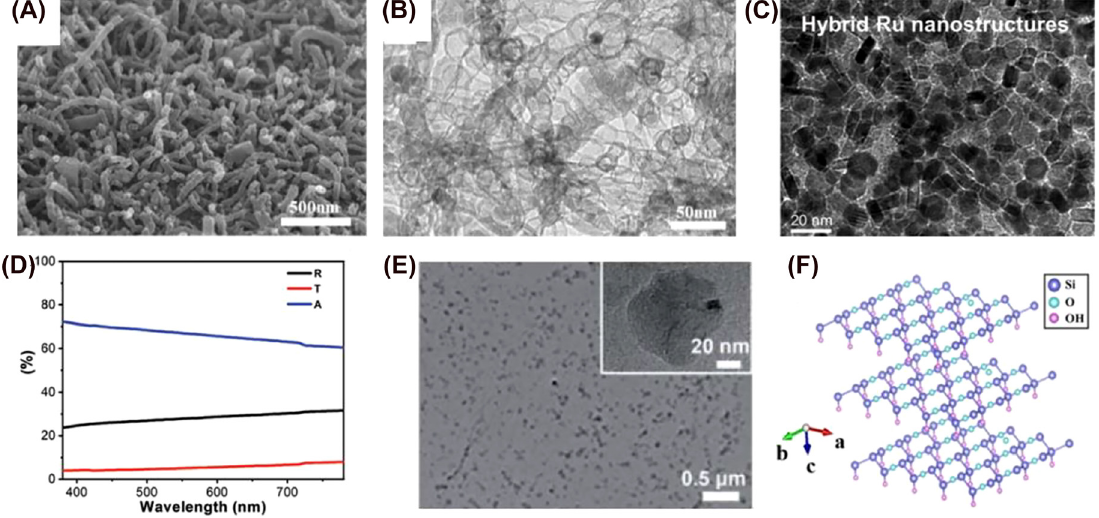
Figure 12: Photoelectrodes based on other photoactive nanomaterials. (A)and(B)correspondtoSEMandTEMimagesofNi 12 P 5 @NCNThybrid[336].Copyright2018,Elsevier.(C)TEMimageofsingle-layerplasmonic Ru nanostructures assembled on the porous cathode. (D) Re fl ection (black line), transmission (red line), and absorption spectra (blue line) of single layer [337]. Copyright 2020, Royal Society of Chemistry. (E) TEM image of SiC/rGO PE. Inset image is a magni fi ed TEM image